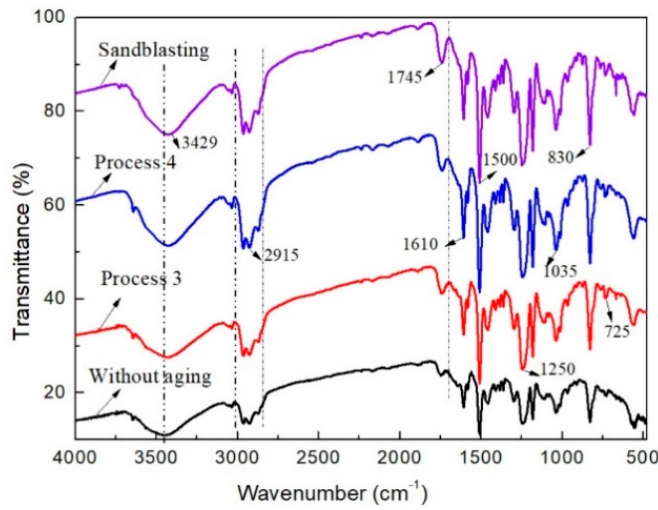
Figure 12. Fourier Transform Infrared Spectroscopy (FTIR) spectrum of the adhesive under different conditions.